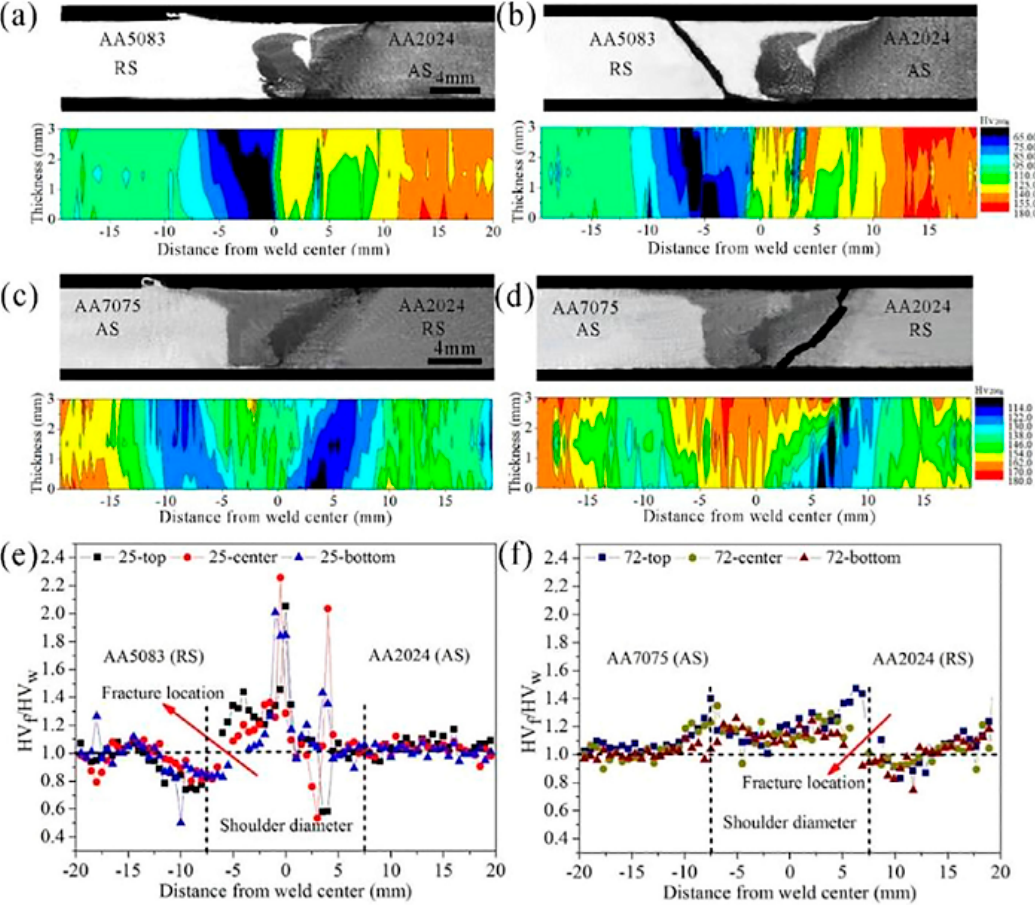
Figure 11. Cross-sectional macrostructures and hardness distributions of the FSWed dissimilar joints: ( a ) 25-joint before fracture, ( b ) 25-joint after fracture, ( c ) 72-joint before fracture, ( d ) 72-joint after fracture; hardening level across the FSWed joints: ( e ) 25-joint and ( f ) 72-joint, reproduced from [13], with permission from Elsevier, 2018. Note: 25-joint means AA2024-AA5083 and 72-joint means AA7075-AA2024 joint.